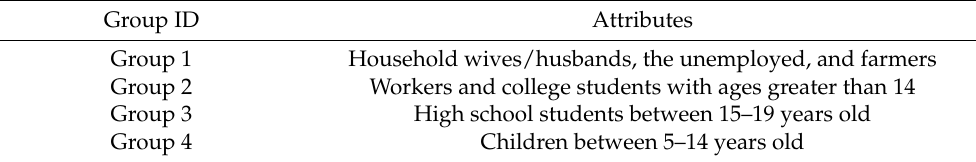
Table 2. Four groups of people.